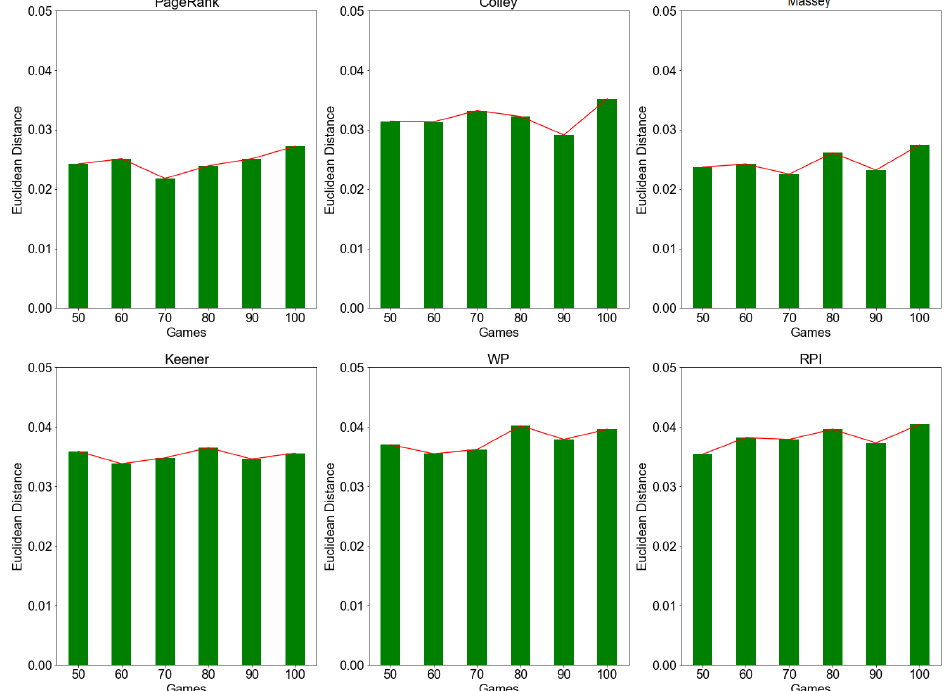
Figure 2. Rating stability based on Euclidean distance by expanding window approach. The figure ( t ) for PageRank, Colley, Massey, Keener, WP, and RPI above shows that the distance value d 2 EW methods increases over time at incremental window size (i.e., an increase of 10 games per window). Smaller distance value indicate higher rating